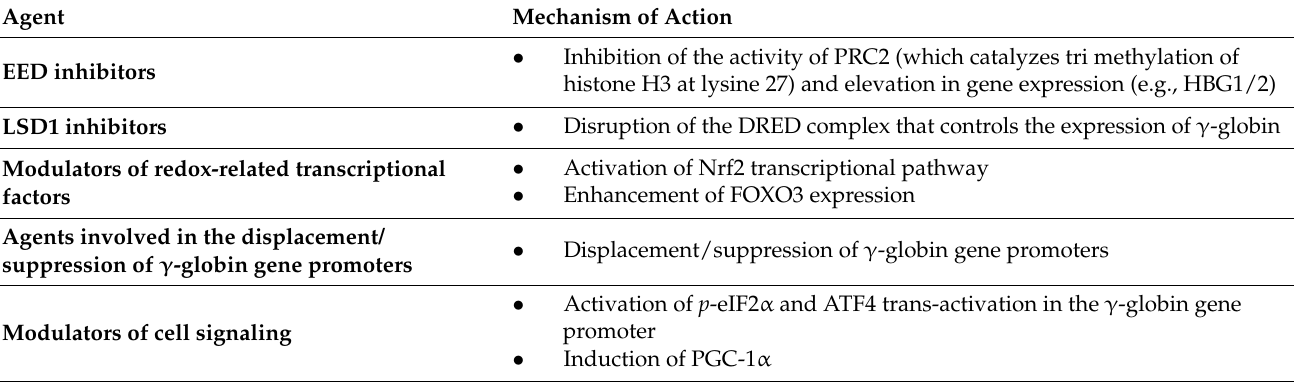
Table 2. Mechanism of action of novel experimental strategies for HbF